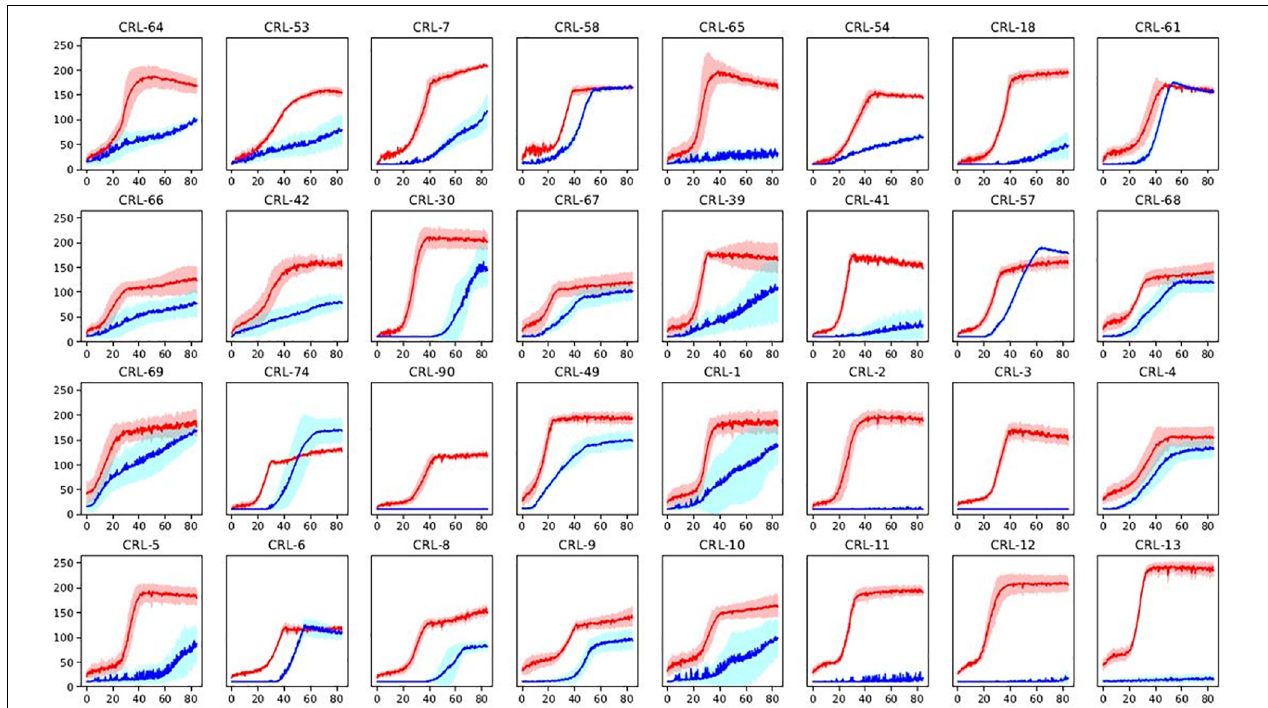
FIGURE 6 | Sugar utilization of a representative part of Brettanomyces collection. Strains grown in media with glucose (red) or maltose (blue) as sole carbon source. Shaded curves are representing standard deviations between triplicates. Y -axis represents yeast growth quantified by Bvalue in Biolog. X -axis represents time in hours. Graphs of the full-collection can be found at Supplementary Figure S1 . Statistical tests of the current data on maltose assimilation can be found in Supplementary Material .